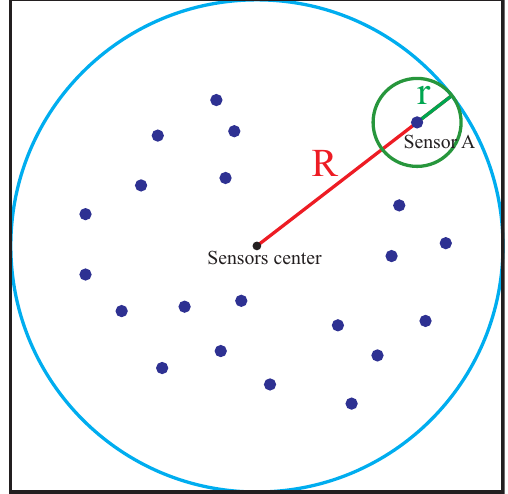
Figure 1. System Coverage Rate Schematic